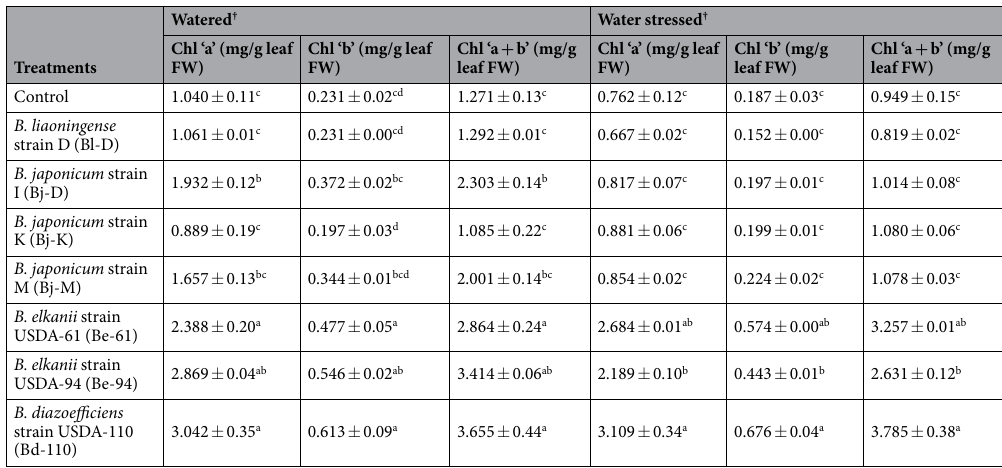
Table 1. Inoculation effects of non-rhizobitoxine- and rhizobitoxine-producing Bradyrhizobium strains on the chlorophyll content of soybean plants using the DMSO method under watered and water-stressed conditions. † Values are the means of six-replication ± standard error. Values with the same superscripts within column indicate no significant difference with P ≥